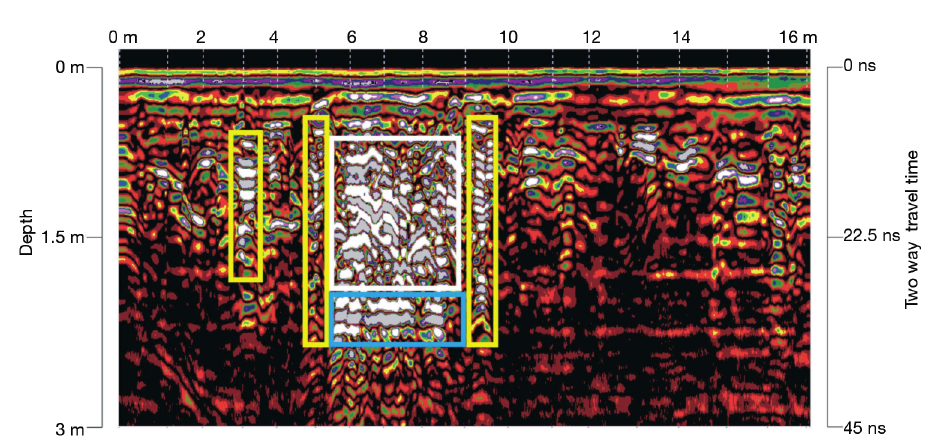
Fig. 4. Migrated and stacked GPR section Alb 4.8 (see fig. 3 for line position). Yellow boxes indicate anom- alies due to wall response while blue box indicates a flat high-energy reflection probably due to a buried floor. The white box indicates a room filled up with